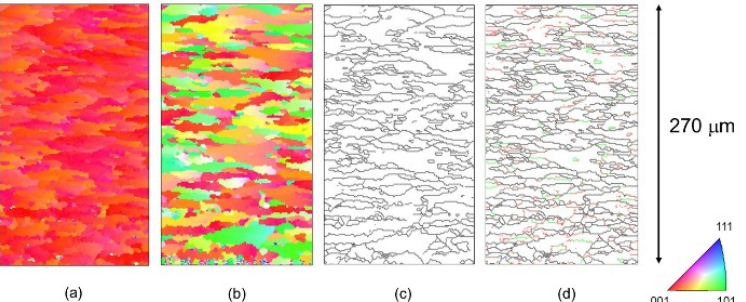
Figure 12. EBSD maps of a grained CLC film. ( a ) IPF-ND map, ( b ) IPF-SD map, ( c ) grain boundaries (15 ◦ < θ < 65 ◦ ), and ( d ) sub-boundaries ( − : 2 ◦ < θ < 5 ◦ , − : 5 ◦ < θ < 10 ◦ , and − : 10 ◦ < θ < 15 ◦ ) and grain boundaries ( − : 15 ◦ < θ < 65 ◦ ). Power was 4.0 W, and the scan velocity was 12 mm/s.